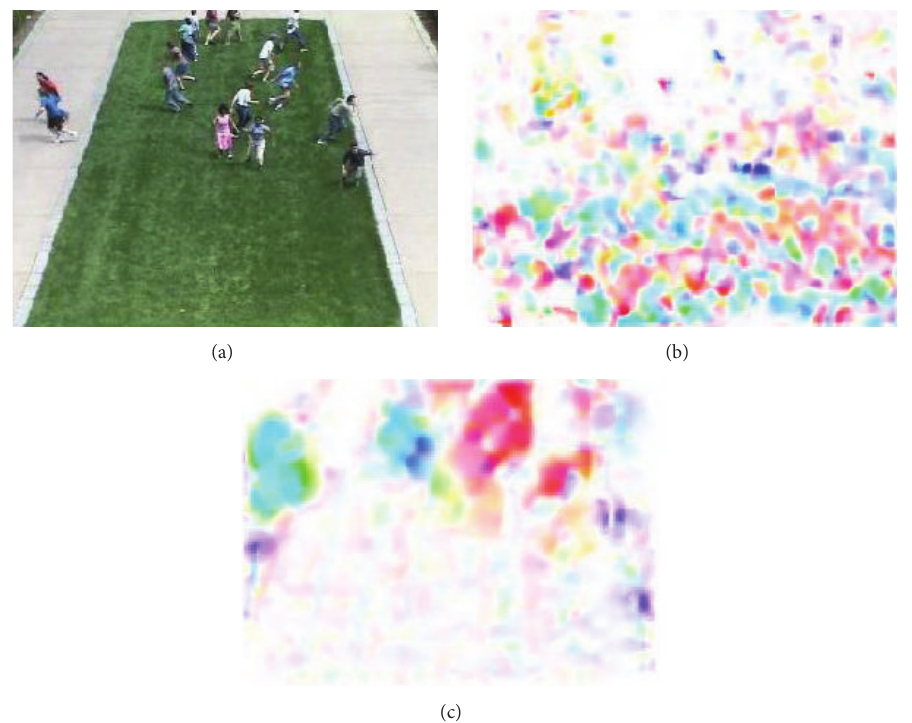
Figure 2: Comparison of optical flow and streak flow. (a) The original image. (b) Optical flow of the original image. (c) Streak flow of the original